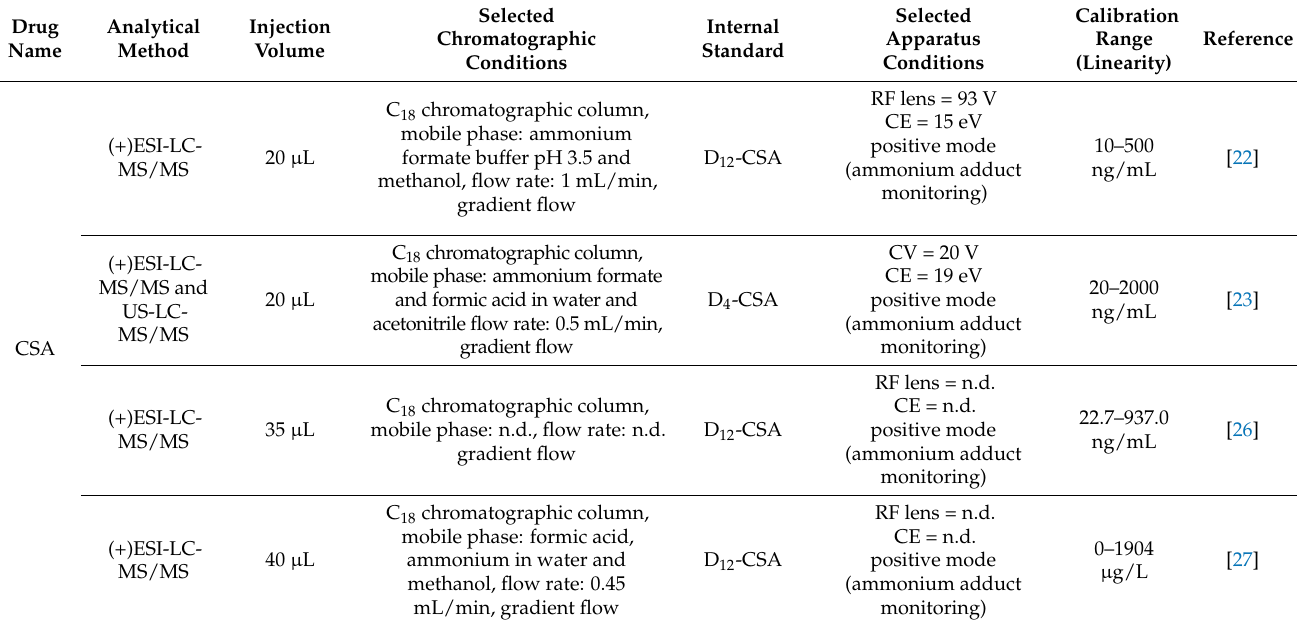
Table 3. Summary of analytical characteristics of immunosuppressive drug assays in common with microsampling